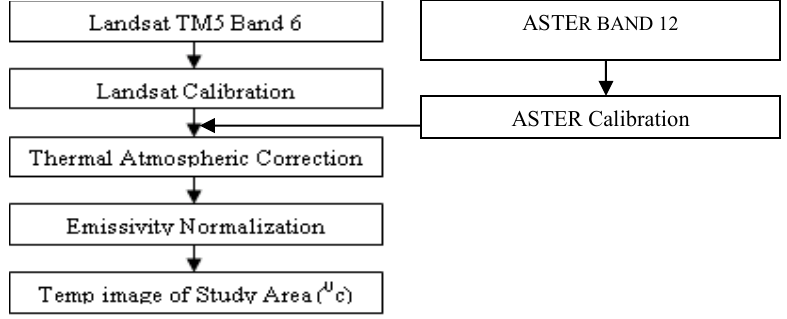
Figure 3. Methodology used in current